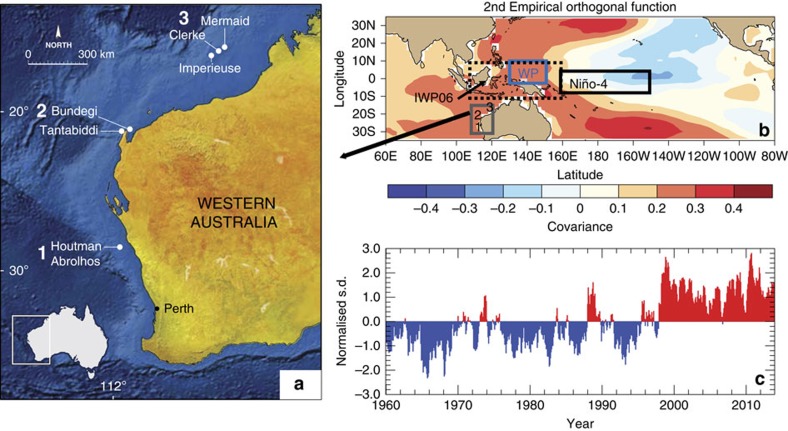
Southeast Indian Ocean reefs and tropical Indo-Pacific SST variability.(a) Locations of the three reef areas (1–3) sampled for long coral cores, (b) rotated empirical orthogonal function 2 (REOF2) covariance of ERSSTv3b15 anomalies, and (c) REOF2 time series, 1960–2013, which explains 21% of the variance. The WPG11 is defined as the standardized difference between average SST over the Niño4 domain14 (black box) and the Western Pacific (WP; blue box), while the Western Australian region is highlighted in grey with coral sampling locations indicated, 1, Houtman Abrolhos, 2, Ningaloo Reef and 3, Rowley Shoals. The black-dashed box marks the Indonesian warm pool region (IWP06 (ref. 26)).